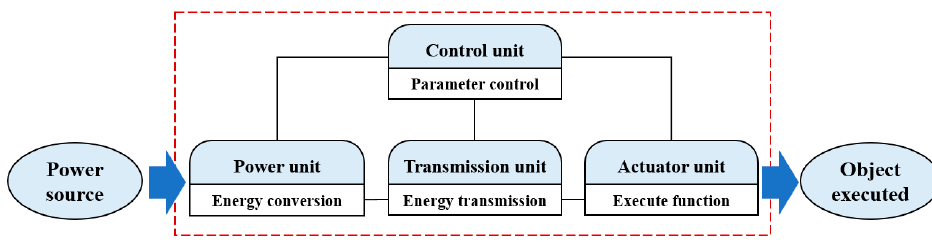
Figure 10. Four basic subsystems of artificial systems.